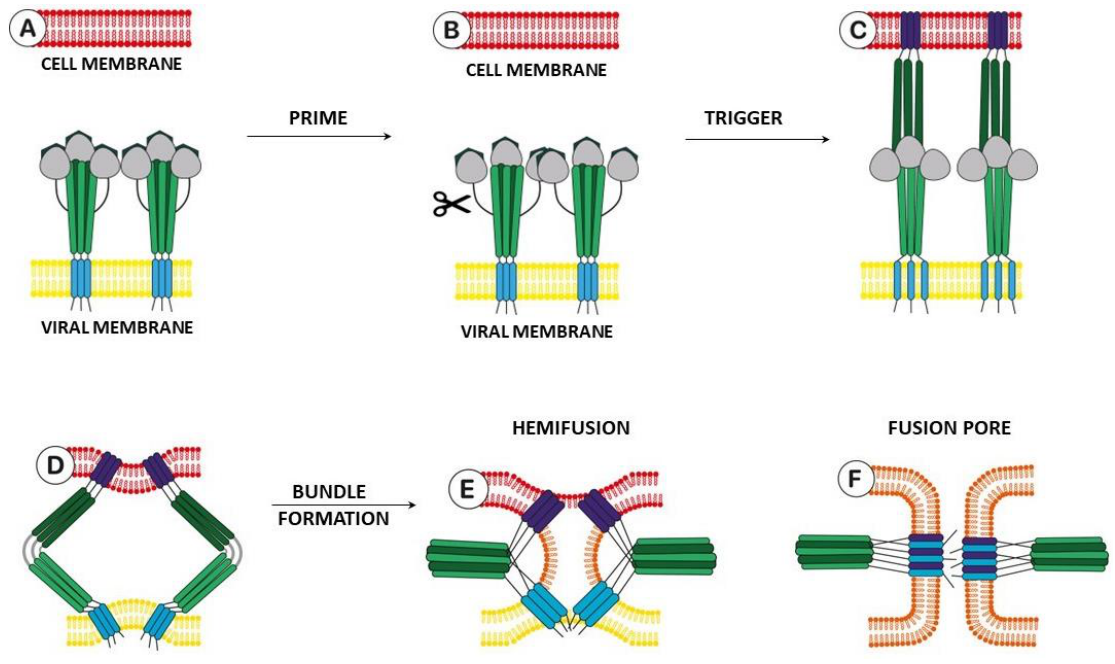
Figure 2. Model of the fusion process of viral and cellular membranes (adapted from [4]).